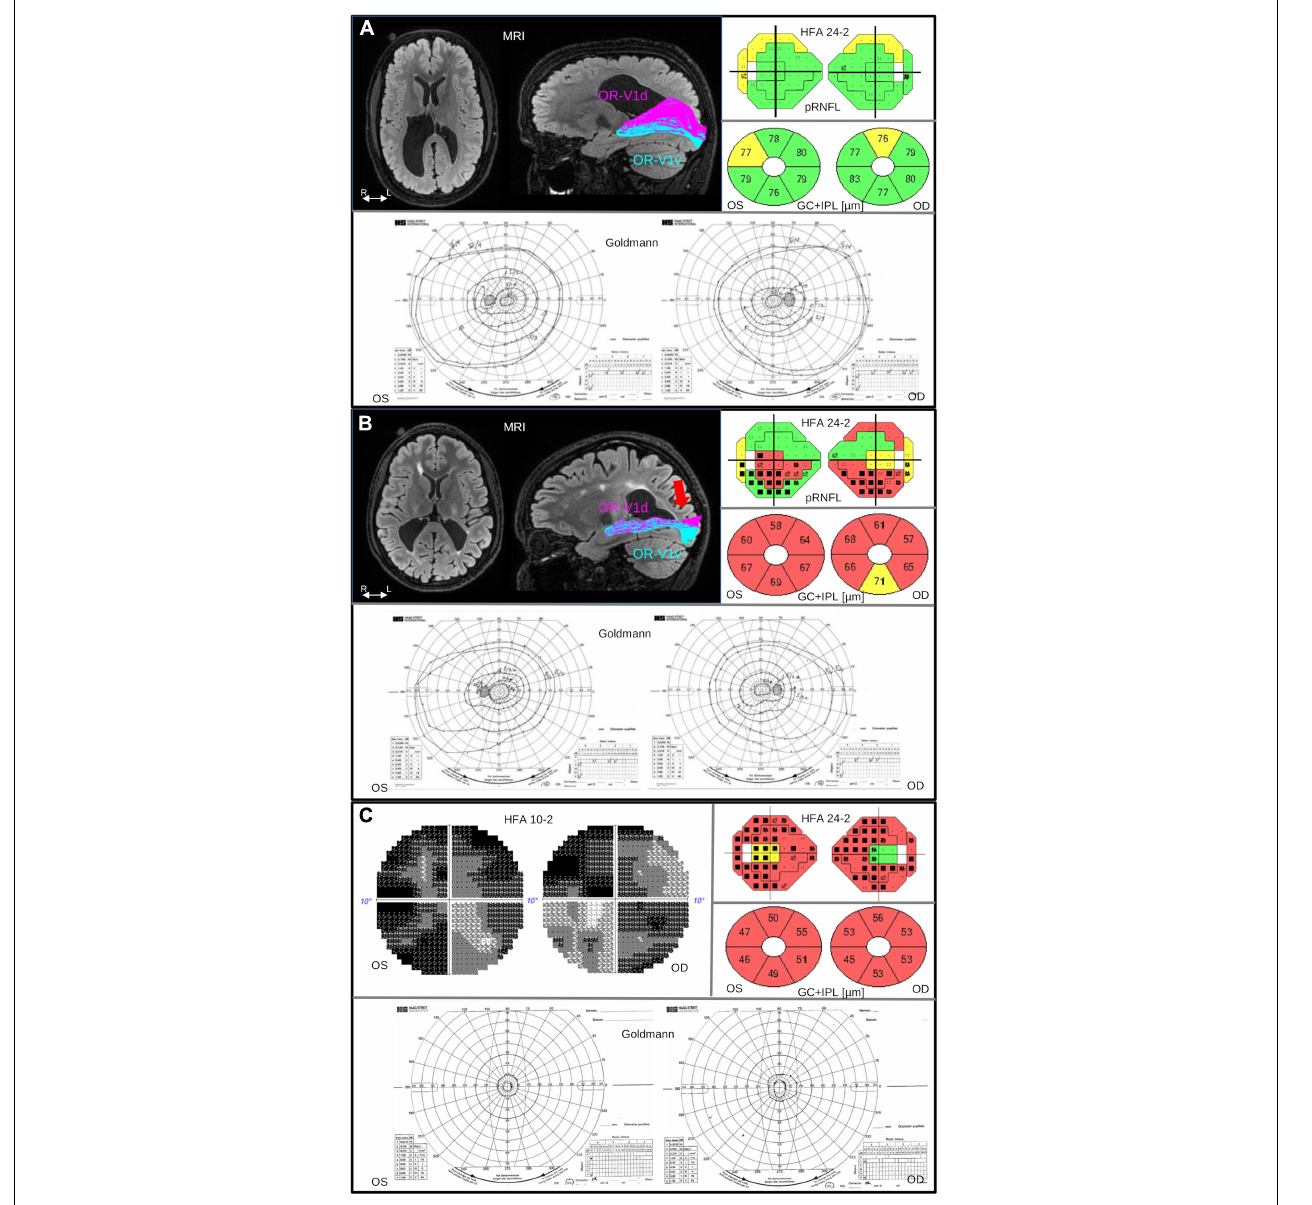
FIGURE 1 | Brain injuries were examined with MRI, with salient findings illustrated on axial FLAIR image (left). Injuries to the OR were investigated with fiber tractography, with results overlaid on a sagittal FLAIR image (right), dividing the OR into parts OR-V1d (magenta) and OR-V1v (cyan) projecting to the dorsal (V1d) and ventral V1 (V1v) fMRI activation maps, respectively, described in Lennartsson et al. (2018). The pRNFL and GC+IPL thickness was measured with OCT. The pRNFL result is visualized in colors together with the results from VF examination using HFA 24-2 and GC+IPL is shown in donuts below. Color code green indicate normal, yellow; borderline and red; abnormally thin. The color codes are automatically generated and based on the reference data in the software of OCT. Visual field function was examined with Humphrey Field Analyzer (HFA) and Goldmann perimetry. The colored visual field maps show VF sensitivity (Sita Fast 24-2) in relation to corresponding pRNFL thickness. Normal VF sensitivity is represented by small single black dots, defects are shown as gray or black squares (black = deeper defect). Goldmann was performed in order to examine the peripheral VF. (A) Case 2 in Table 1 : 19-year-old, born at GA 26 weeks, with bilateral perinatally acquired WMDI (R > L). Suffering from mild left-sided spastic CP, and dorsal stream dysfunction. VA is 1.0 (logMAR 0.00), no strabismus, and sub-grouped as CVI A1. MRI image shows bilateral WMDI (R > L) with periventricular WM reduction, especially posteriorly and on the right side. Fiber tractography shows normal ORs bilaterally, here illustrated with the right OR with separation of the OR-V1d and OR-V1v, dominating the superior and inferior portions of OR, respectively. OCT showed pRNFL and GC+IPL thickness values within normal range. The VF sensitivity and the outer borders were normal. (B) Case 7 in Table 1 : 25-year-old woman, born at GA 33 + 0. She presented with early onset left esotropia and nystagmus. At 4 years of age VA was subnormal in both eyes and large cupping of the optic disks was noted. She has no CP. VA 0.63 (logMAR 0.20), and dorsal and ventral stream dysfunction and CVI A2. MRI image shows bilateral WMDI with WM reduction of, especially posteriorly, and extensive gliosis in the periventricular WM. Results of the left OR (right) shows abnormal appearance of the OR-V1d projections, sharing the space normally solely occupied by the OR-V1v projections, and fanning in the subcortical white matter (red arrow), presumably the location of